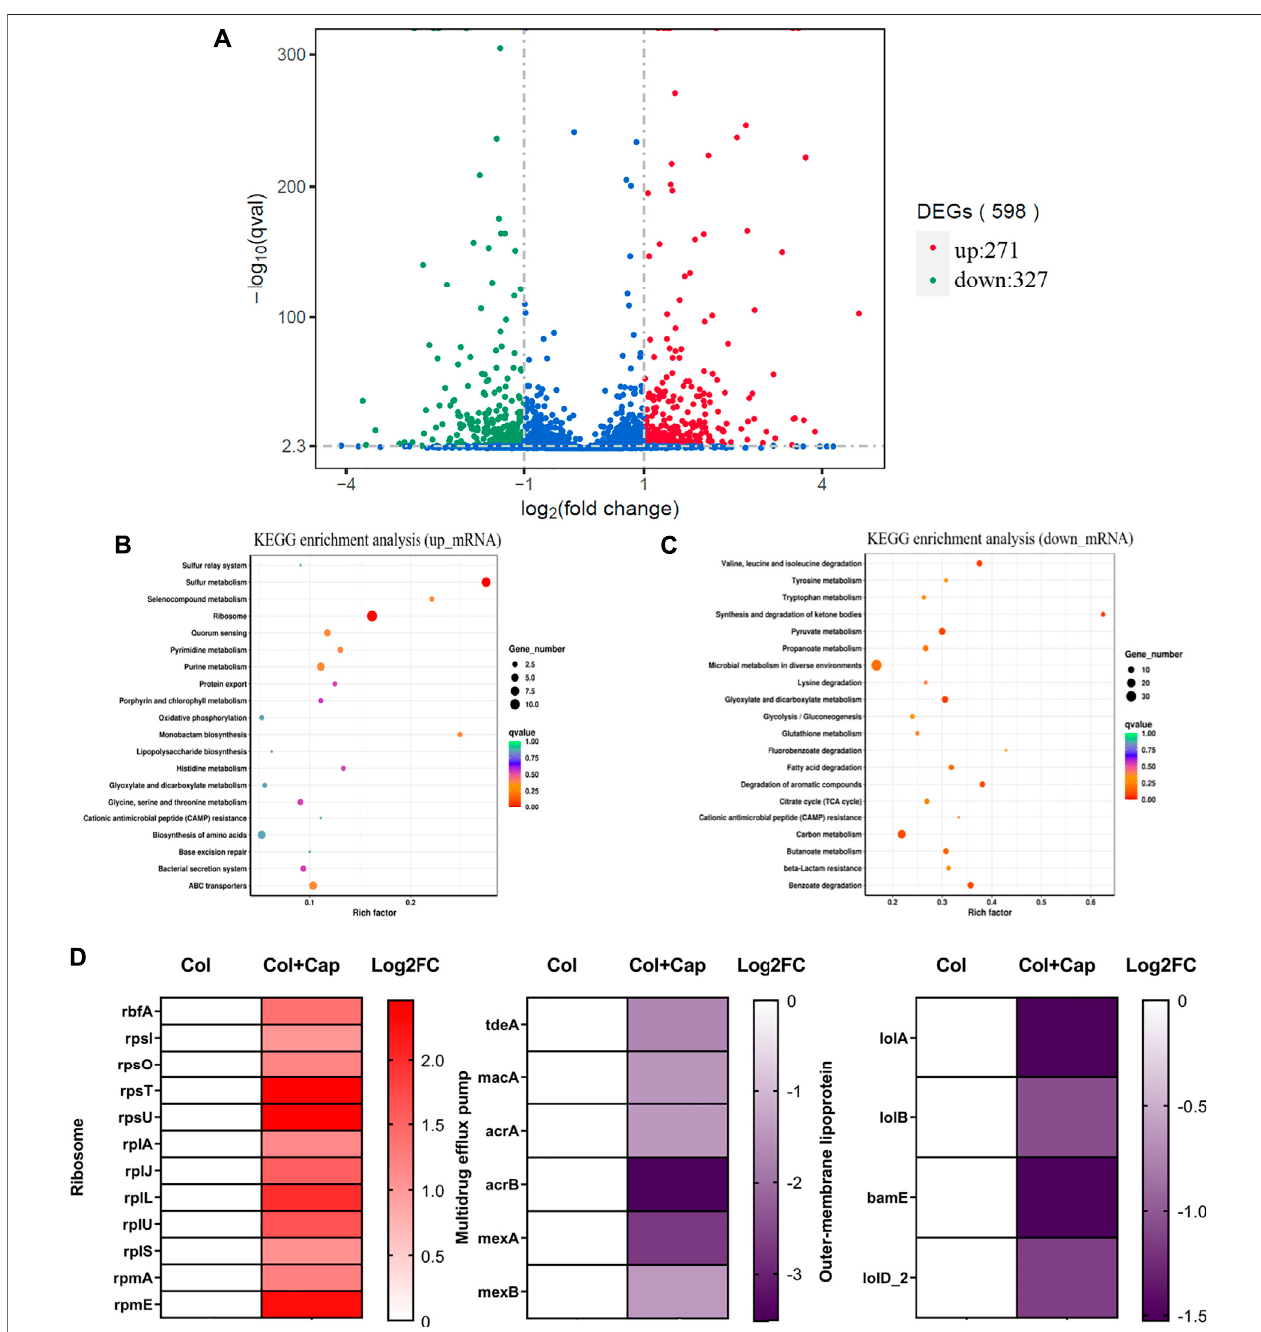
FIGURE8 | TranscriptomeanalysisofATCC19606-R after exposureto colistin (2 μ g/mL) alone or the combination of colistin (2 μ g/mL) plus capsaicin (32 μ g/mL). (A) :Differentialgenevolcanomap. (B) :KEGGenrichmentanalysisofup-regulation genes. (C) :KEGGenrichmentanalysisofdown-regulationgenes;thecolorofthedot represents the size of the Q value, and the size of the dot represents the number of differential genes. (D) : Differentially expressed genes of ribosomes, multidrug ef fl ux pump and outer membrane lipoprotein. Col: colistin alone; Col + Cap: the combination of colistin and capsaicin.